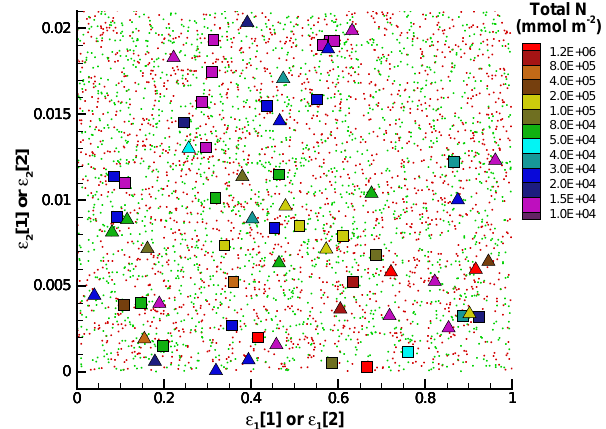
Fig. 5. Points (large triangles and squares) in 4-D ε i [ j ]-space that resulted in total steady state N standing stock ( N Total ) greater than 10 4 mmolm − 2 . Triangles mark locations and magnitude of N standing stock for ε 1 and ε 2 in box [1], while squares mark loca- tions and N standing stock for ε 1 and ε 2 in box [2]. Also shown as small points are a subset of the ε 1 and ε 2 in box [1] (green) and box [2] (red) from the 100,000 Monte Carlo simulations that have N Total < 10 4 mmolm − 2 . Note, the y-axis range from 0 to 0.021 captures all points that meet the minimum N Total requirement of 10 4 mmolm − 2